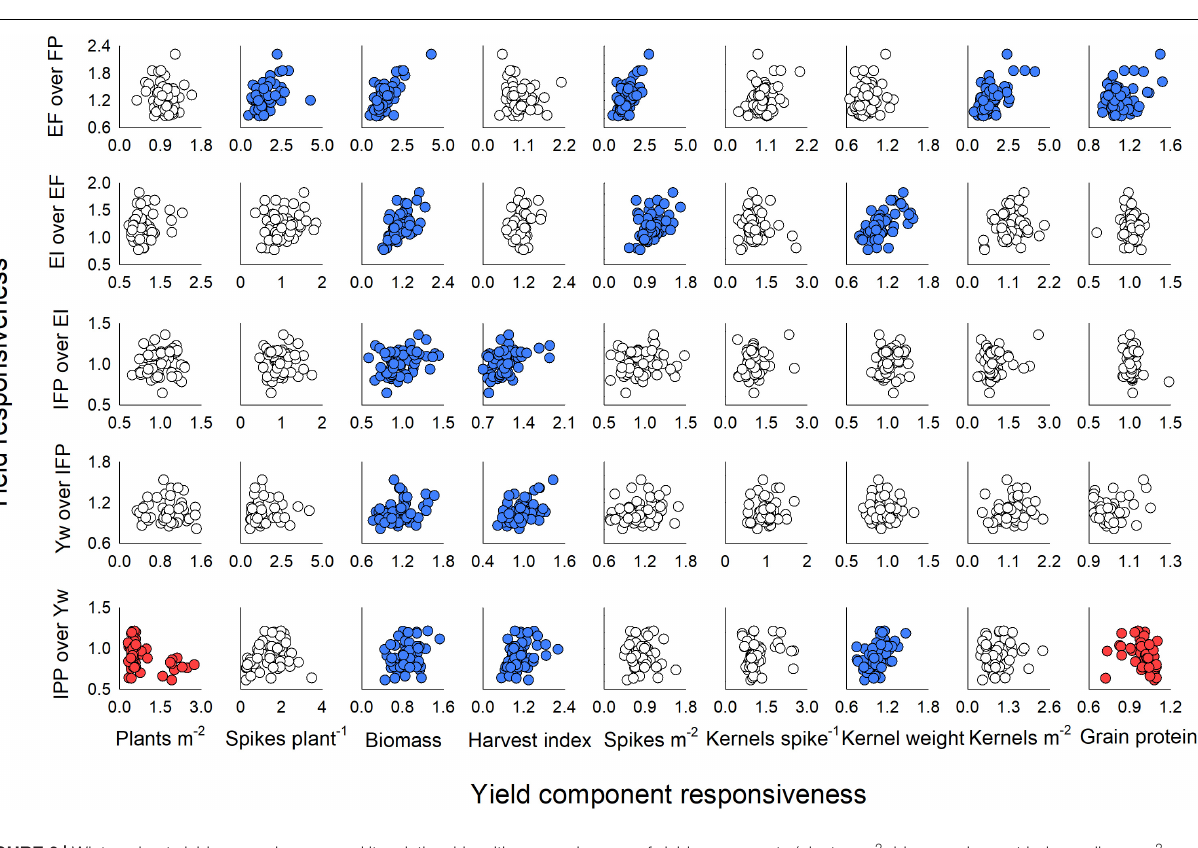
FIGURE 6 | Winter wheat yield responsiveness and its relationship with responsiveness of yield components (plants m − 2 , biomass, harvest index, spikes m − 2 , kernels spike − 1 , and kernel weight) and grain protein concentration for each step of management intensification evaluated in the current study. Responsiveness values were calculated as enhanced fertility (EF) over farmer’s practice (FP) (first row); ecological intensification (EF) adding a fungicide application at Zadoks GS55 over EF (second row); increased foliar protection (IFP), adding a fungicide application at Zadoks GS31 to EI (third row); rainfed yield potential (Yw), adding micronutrients at Zadoks GS31 to the IFP (fourth row); and increased plant productivity (IPP), reducing the seeding rate from Yw (fifth row). Circles in blue denote a significant positive and circles in red a significant negative relationship between variables at p <